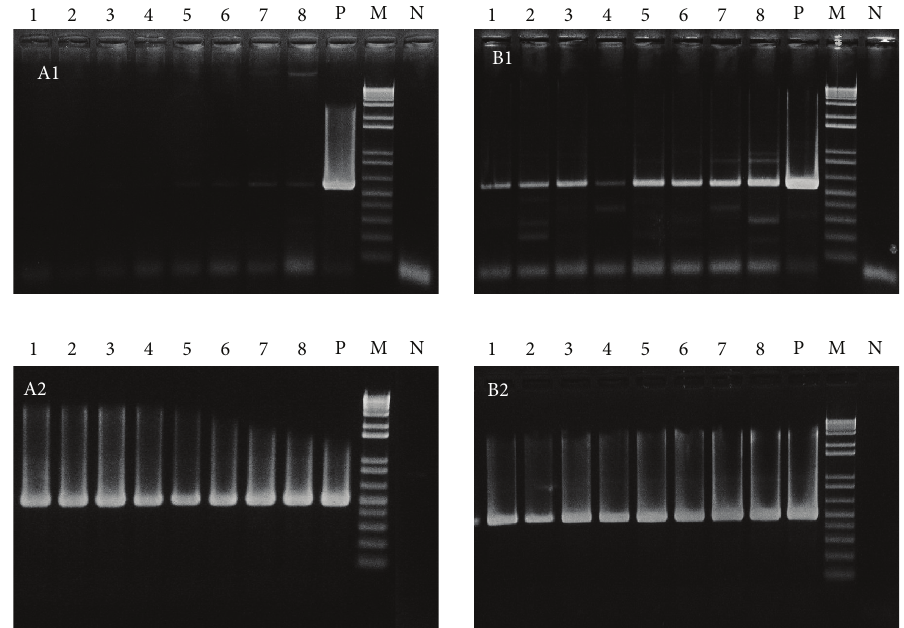
Figure1:ComparisonofPCRandnestedPCRtargeting ctxA withtemplateDNApreparedfromacommercialwholegenomeDNAextraction kit ((A1), 1st-PCR; (A2), nested PCR) and a commercial plasmid DNA extraction kit ((B1), 1st-PCR; (B2), nested PCR). Lane 1, GCDV 10-1; lane 2, GCDV 10-2; lane 3, GCDV 31-1; lane 4, GCDV 34-3; lane 5, GCDV 47-1; lane 6, GCDV 28-2; lane 7, GCDV 37-1; lane 8, GCDV 50-6; lane P, Vibrio cholerae N16961 (positive control); lane M, 100bp ladder size marker; lane N, PCR negative control.